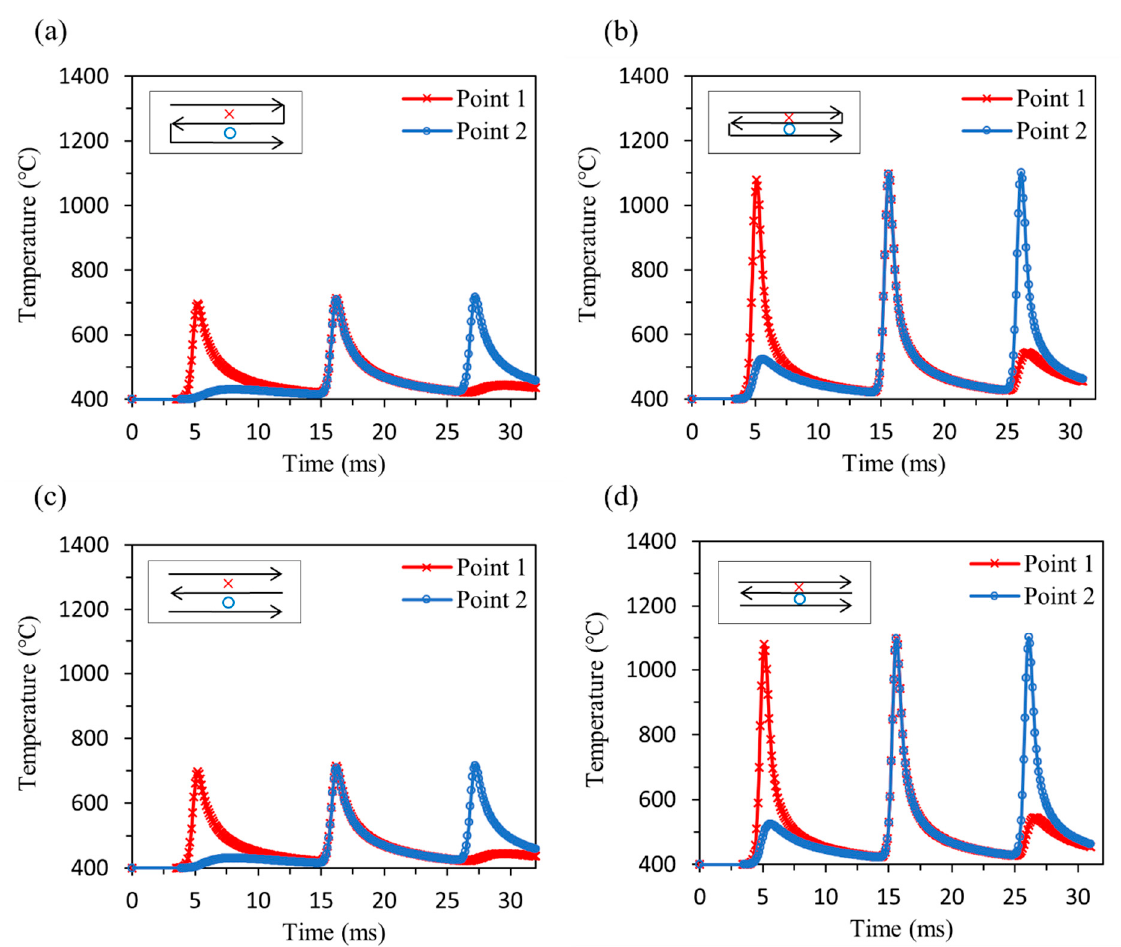
Figure 4. Temporal temperature profile obtained at midpoints between two adjacent scanned lines: ( a ) test 1, ( b ) test 2, ( c ) test 3 and ( d ) test 4 (cross and circle mark in the figure indicate point 1 and point 2, respectively). Table 4. Heating and cooling rate comparison (calculated with the first peaks in the graphs in Figure 5). Test No.